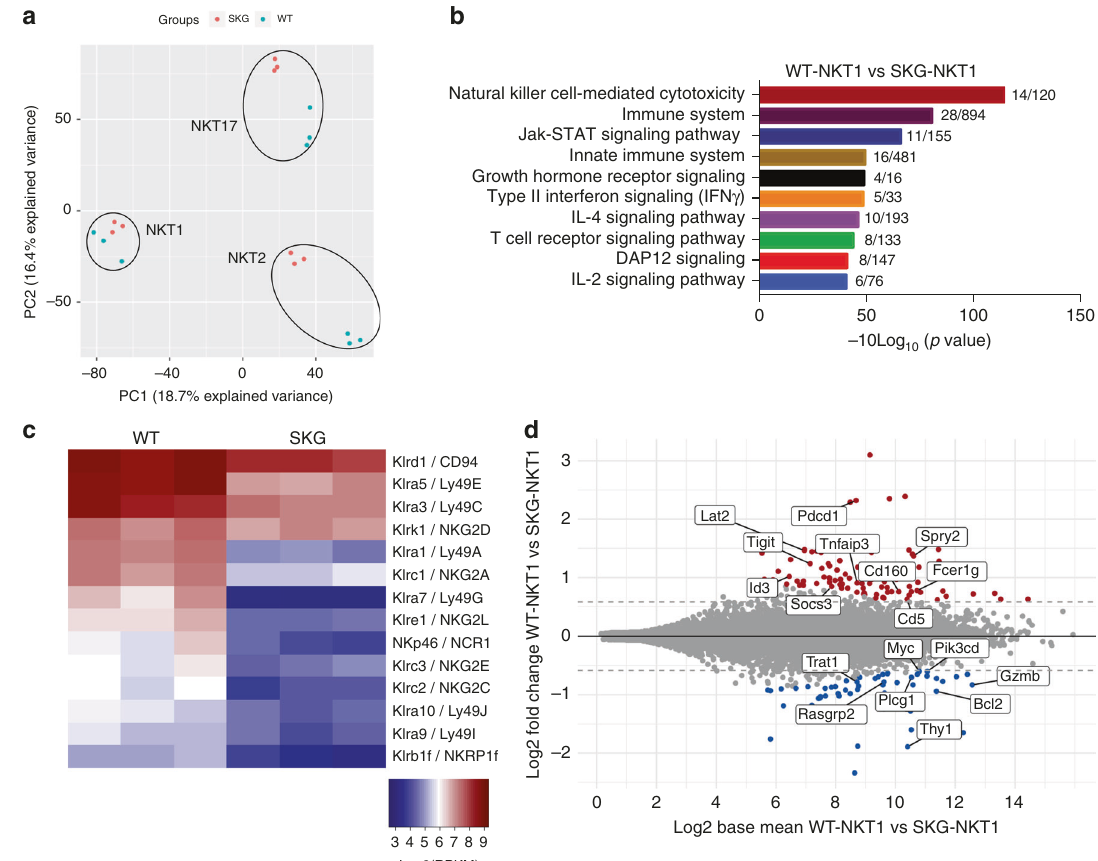
Fig. 4 Transcriptomic analysis of iNKT cell subsets in WT and SKG mice. a Principal component analysis (PCA) of transcriptomes from NKT1, NKT2, and NKT17 cells from WT and SKG thymus tissue. b Enriched pathways comparing NKT1 transcriptomes from WT and SKG mice, numbers of genes affected compared to the number in that category are indicated. c Unscaled Heatmap showing the expression of NK receptors in NKT1 cells from WT and SKG mice. d MA plot of differentially expressed genes (fold change > = 1.5, adjusted p < = 0.1) comparing WT and SKG NKT1